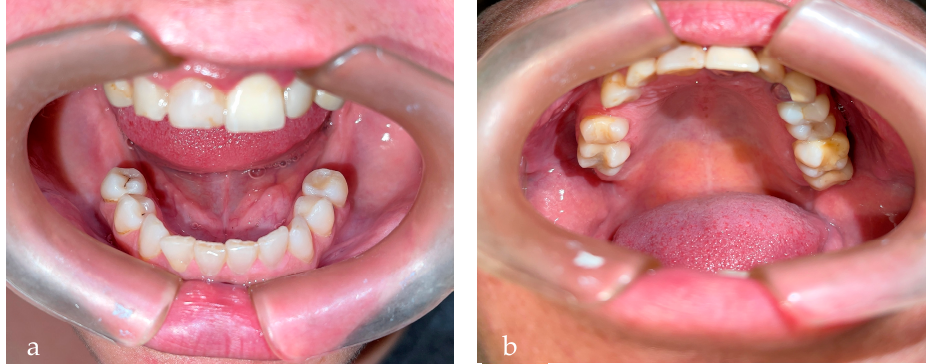
Figure 4. ( a ) Inferior arch missing teeth: 36, 37, 38, 46, 47, and 48; ( b ) superior arch missing teeth: 14, 17, 18, and 28.